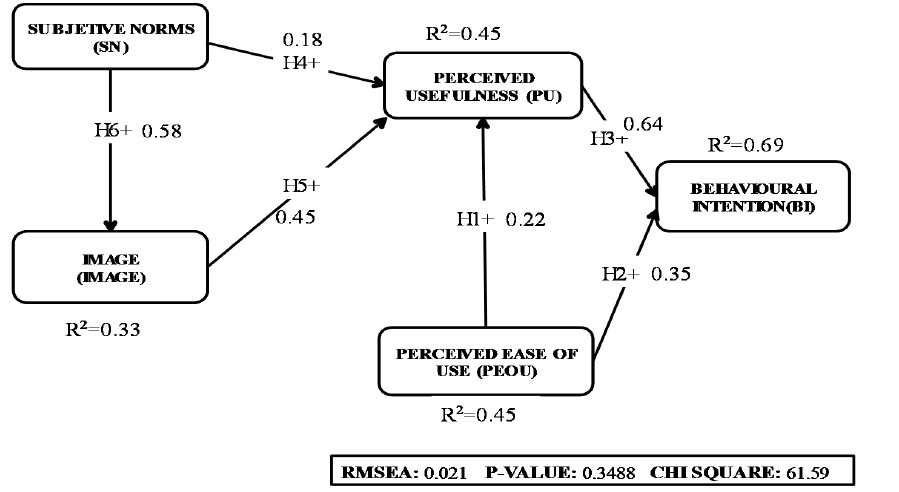
Figure 2. The µBSN acceptance model